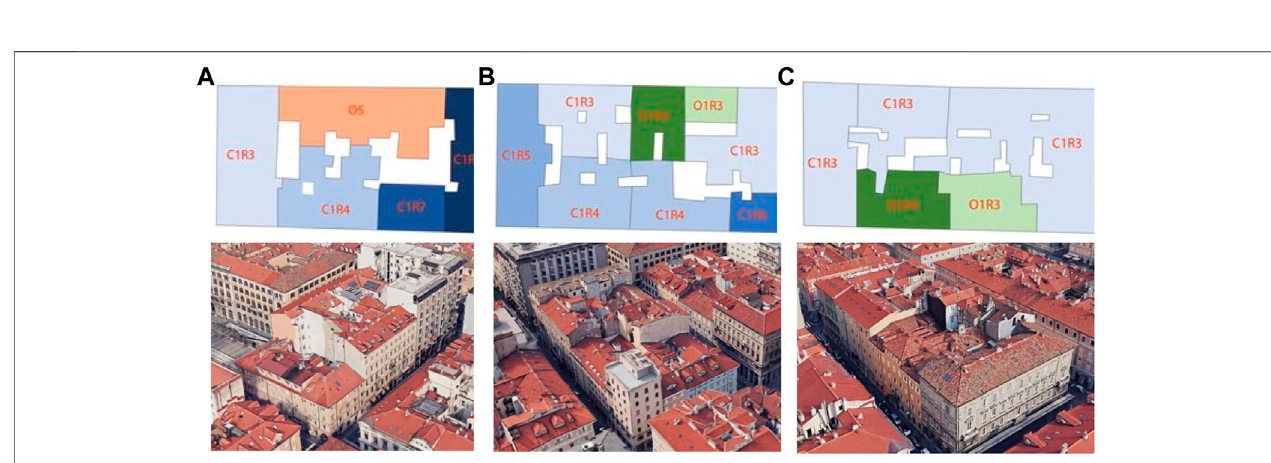
FIGURE 2 | Plan of buildings and photograph of block 3 (A) , block 4 (B) , and block 11 (C) .